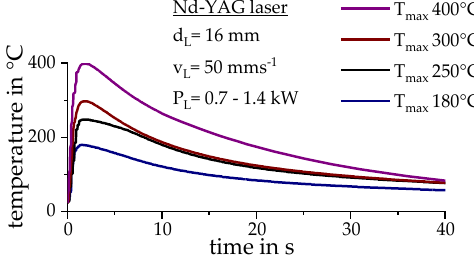
Figure 3. Recorded temperature courses of di ff erent laser heat treatments, described in [25].